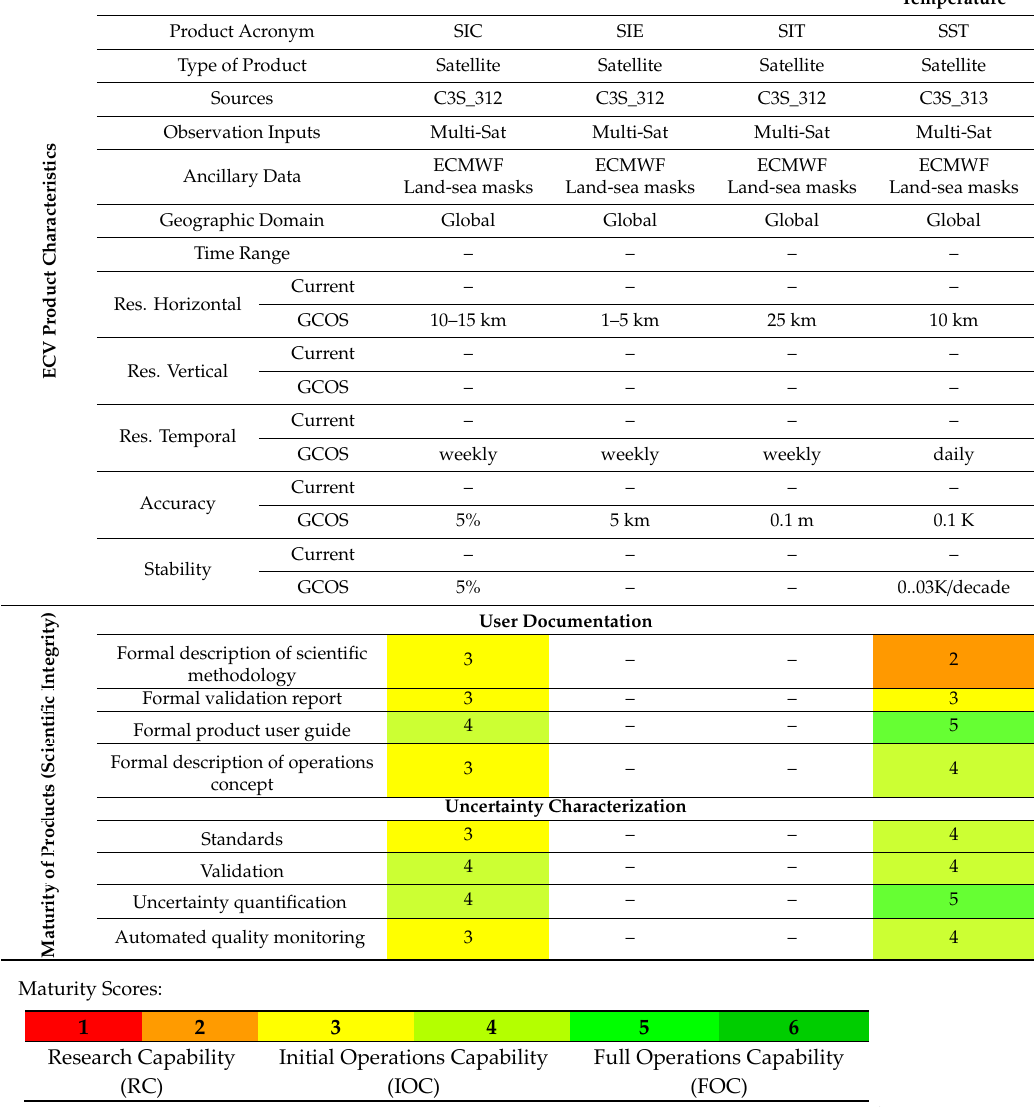
Table 3. Example of the overview of thematic ECV products to provide first level information on “ECV product Characteristics” and “Maturity of Products (Scientific Integrity).” (Note: The